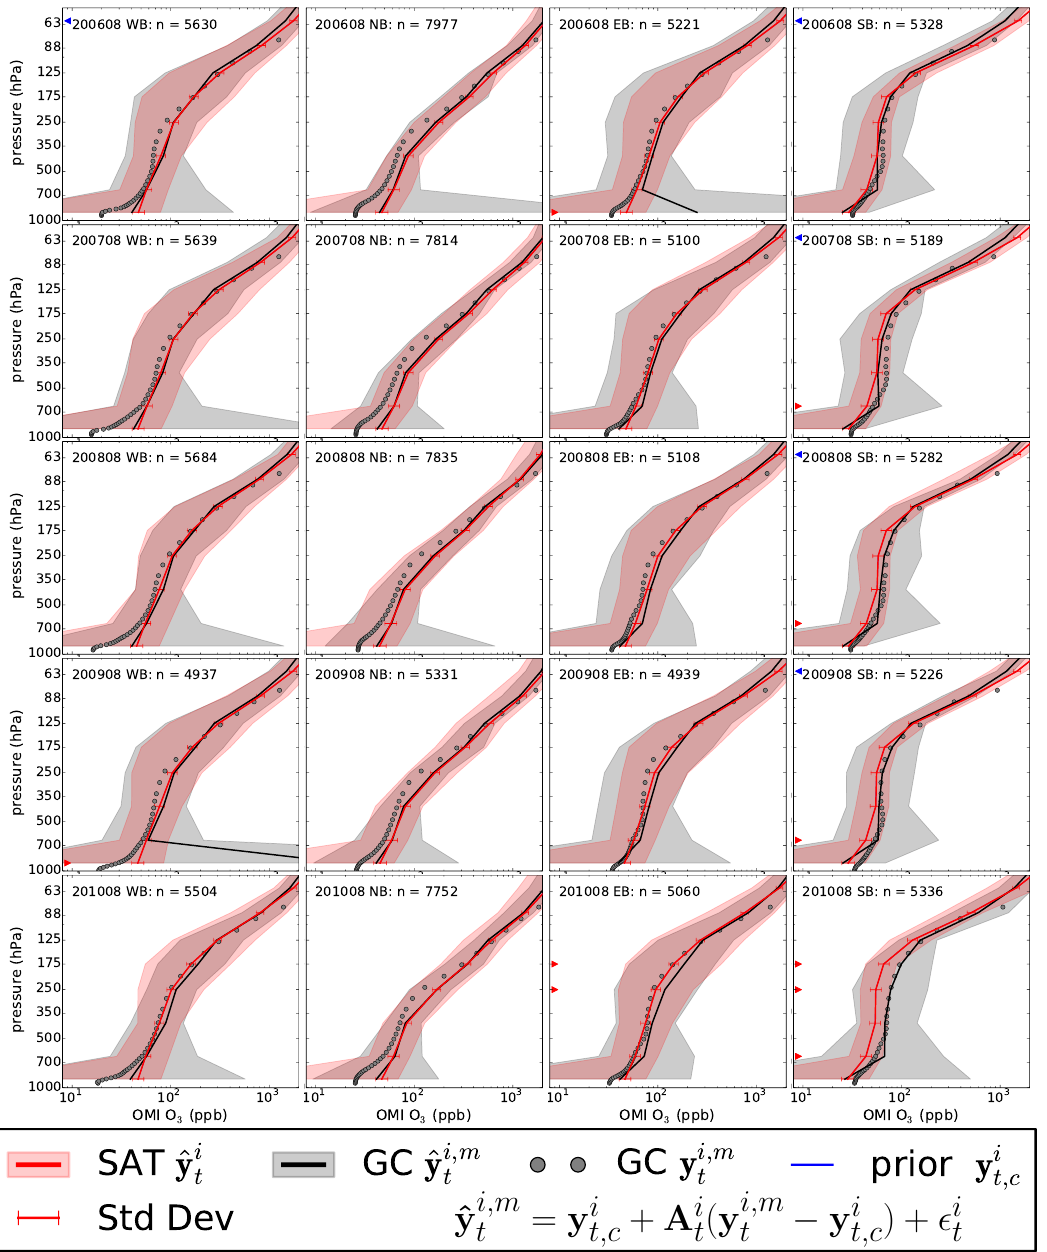
Fig. A4. Same as Fig. A2, but for OMI.